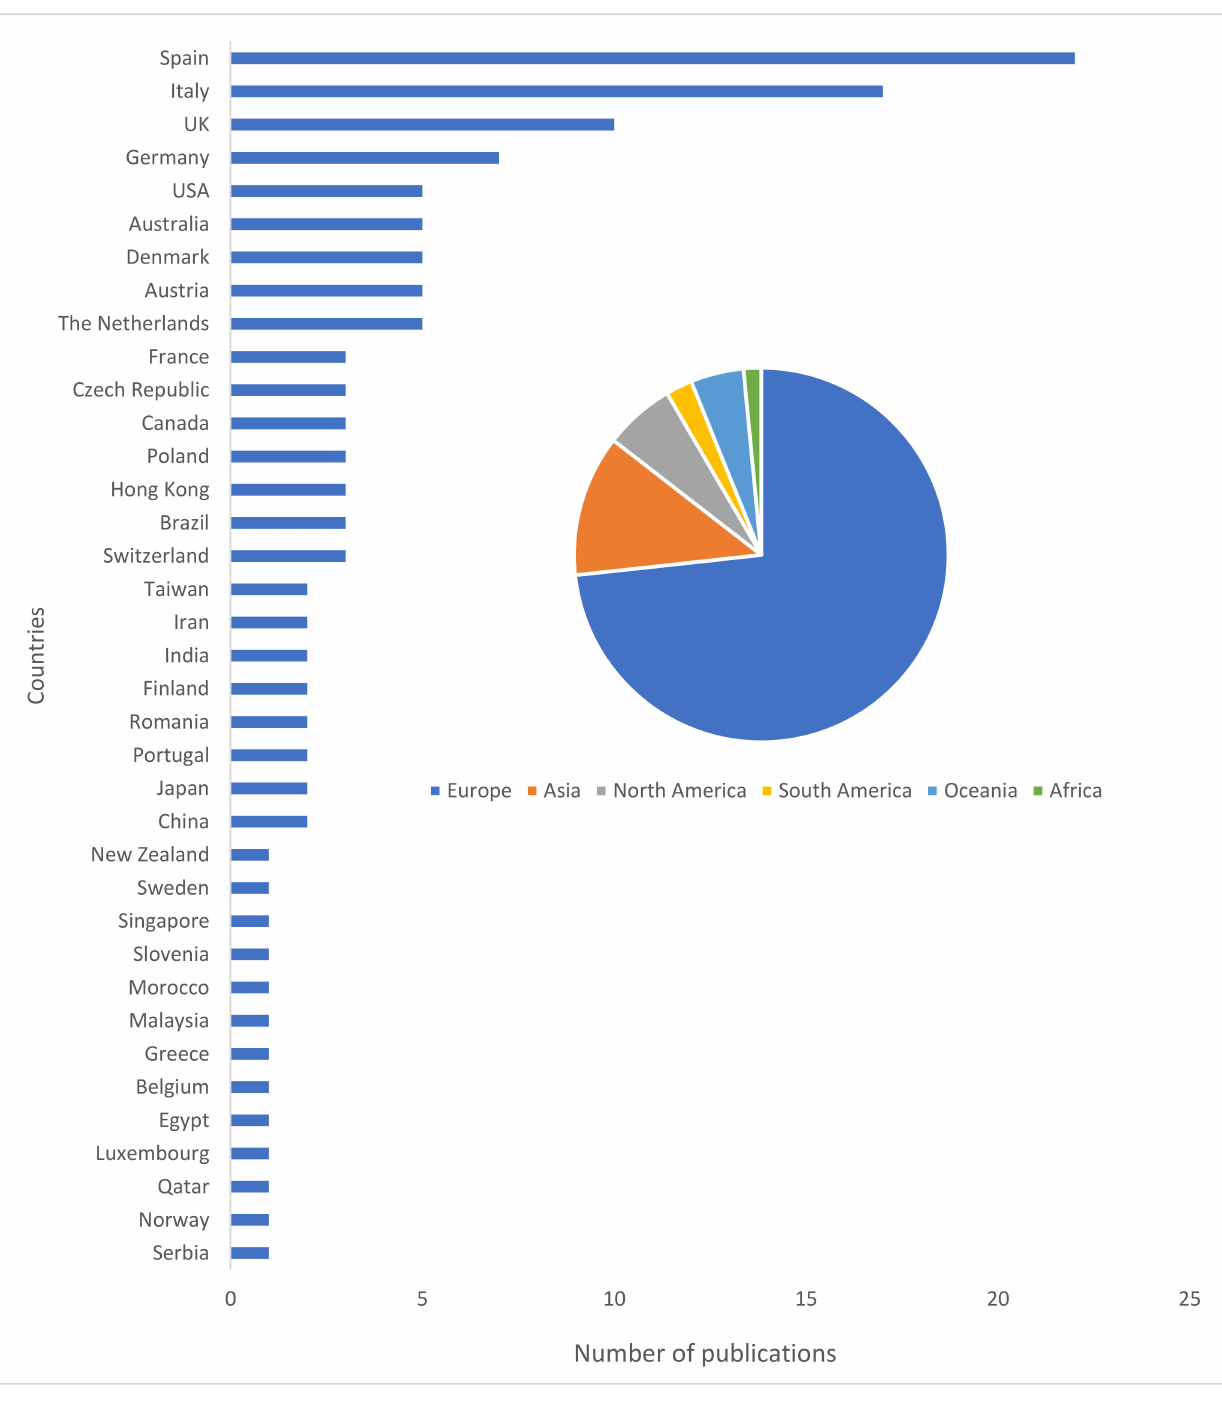
Figure 3. Spatial analysis of the selected